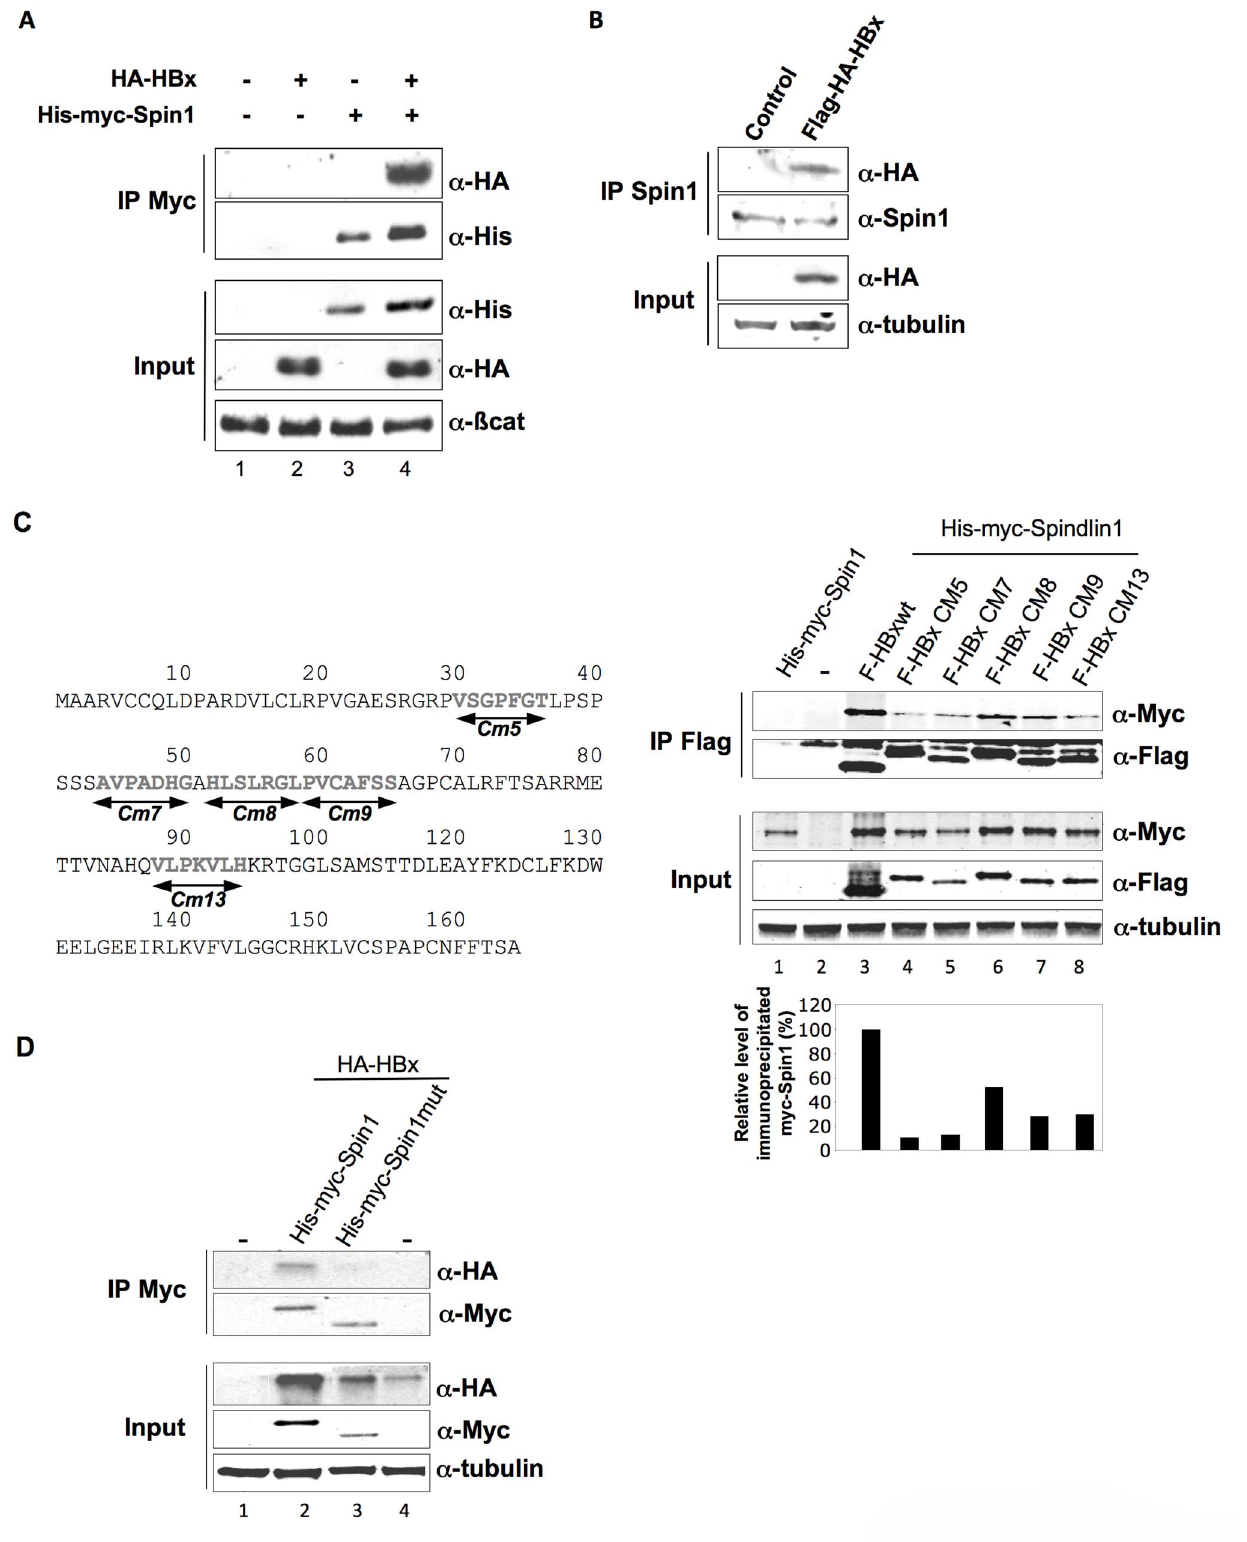
Figure 1. Spindlin1 interacts with HBx. ( A ) Coimmunoprecipitation of His-myc-Spindlin1 (His-myc-Spin1) with HA-HBx using anti-Myc antibodies in HEK293 cells. Proteins in the immune complexes were revealed by Western blotting with anti-His and anti-HA antibodies. The expression of b - catenin was used as loading control. ( B ) Whole-cell extracts, prepared from HepG2 cells transduced with a lentiviral vector encoding Flag-HA-HBx, were immunoprecipitated with anti-Spindlin1 antibodies (IP Spin1). Proteins were detected by Western blotting using anti-HA or anti-Spin1